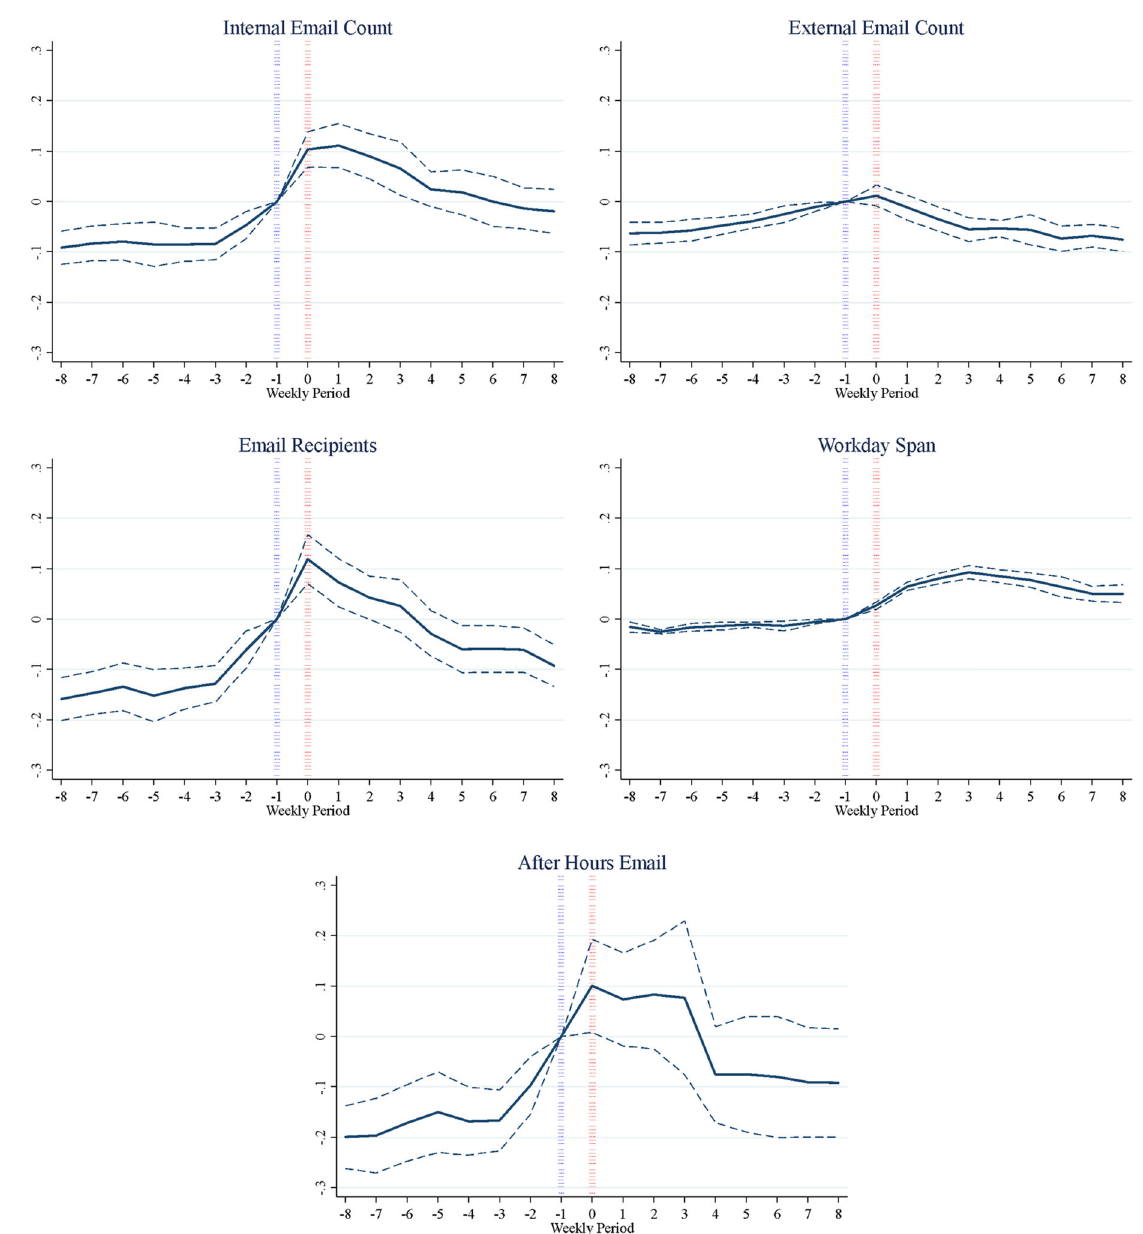
Fig. 2 Impact of COVID-19 lockdown on email measures. Depiction of the coef fi cients from Table